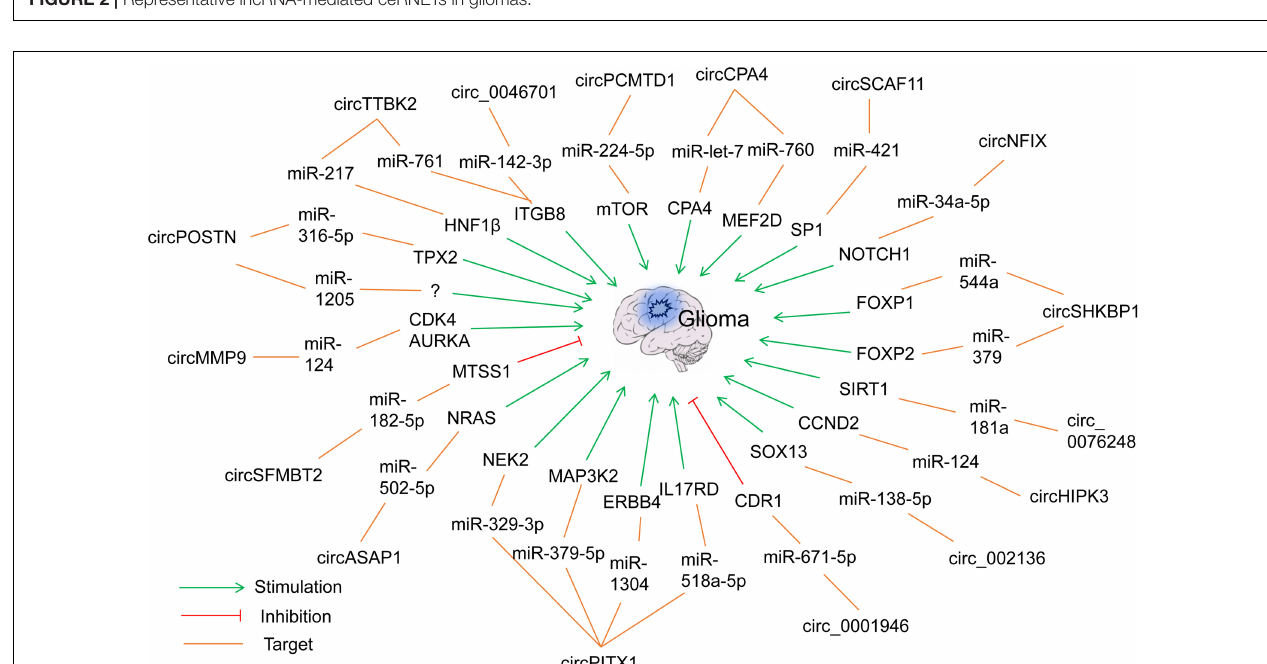
FIGURE 2 | Representative lncRNA-mediated ceRNETs in gliomas.